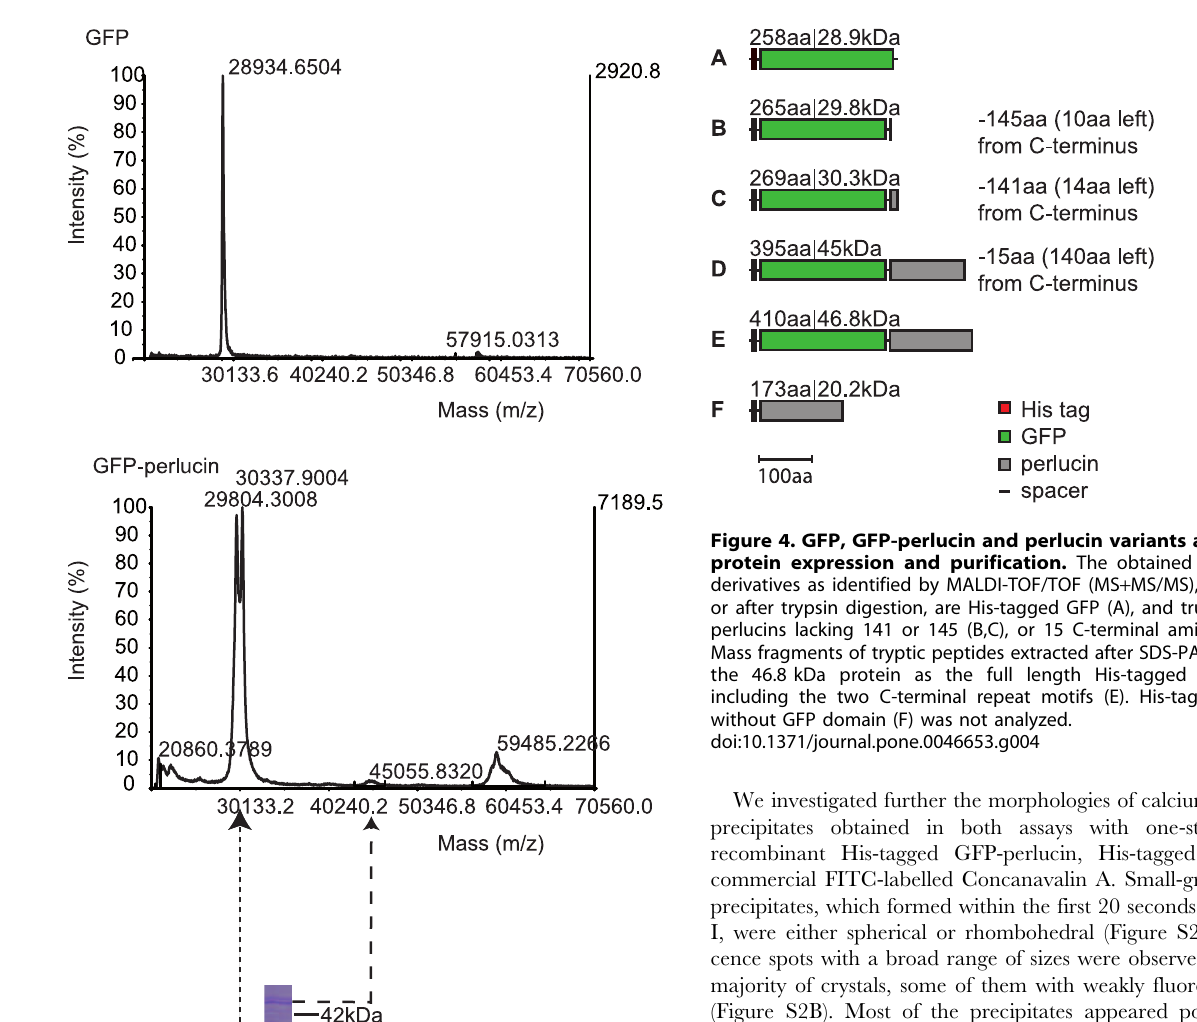
Figure 3. MALDI-TOF/TOF (MS + MS/MS) of GFP-perlucin var- iants. Intact mass analysis of Ni 2 + -NTA eluates of His-tagged GFP (top) reveals the expected molecular mass of 28.9 kDa. His-tagged GFP- perlucin (bottom) yields two major peaks at 29.8 kDa and 30.3 kDa corresponding to truncated protein variants. A minor broad peak at 45 kDa indicates the presence of the 395 amino acid protein (see also Figure 4). Protein dimers could explain additional intact mass peaks in spectra of GFP (57.9 kDa, top) and GFP-perlucin (59.4 kDa, bottom).